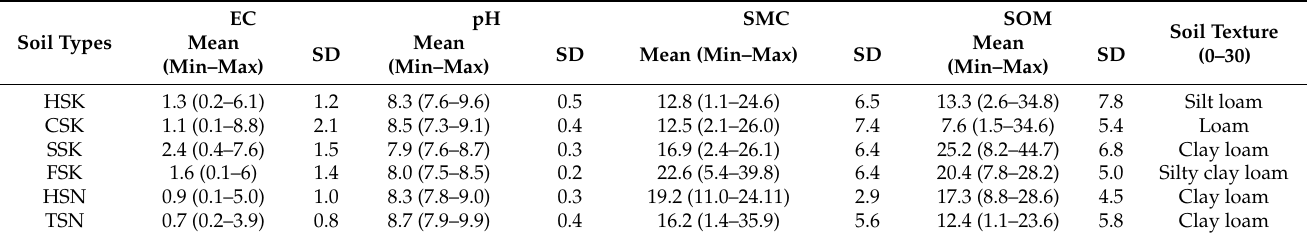
Figure 2. Numerical distribution of the sample points of different soil types. HSK: Haplic Solonchaks, SSK: Stagnic Solonchaks, CSK: Calcic Sonlonchaks, FSK: Fluvic Solonchaks, HSN: Haplic Sonlontzs, and TSN: Takyr Solonetzs. Table 2. Summary statistics of the measured soil attributes of different soil types.